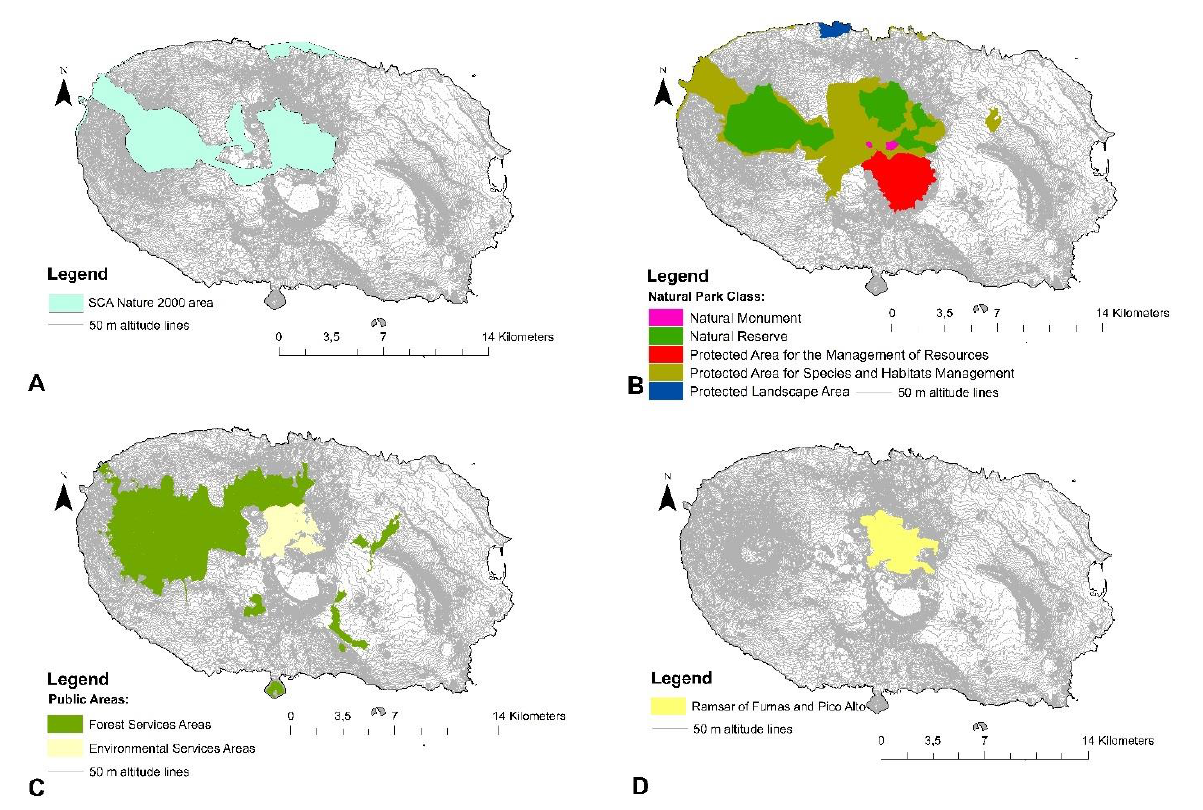
Figure 2. Classified and public areas on Terceira. A: Natura 2000 SCA (Special Conservation Area); B: Terceira Natural Park Areas and their classes, accessed 10 Jun 2016 at http://www.azores.gov.pt/Gra/ srrn-natureza/conteudos/livres/Parque+Natural+da+Ilha+Terceira.htm; C: Terceira public area, accessed 10 Jun 2016 at http://ot.azores.gov.pt/Perimetros-Florestais.aspx#igt-ter. Images were georeferenced in ArcGIS 10; D: Terceira Ramsar classified area of Furnas and Pico Alto, accessed 10 Jun 2016 at https://rsis.ramsar.org/ris/1805.